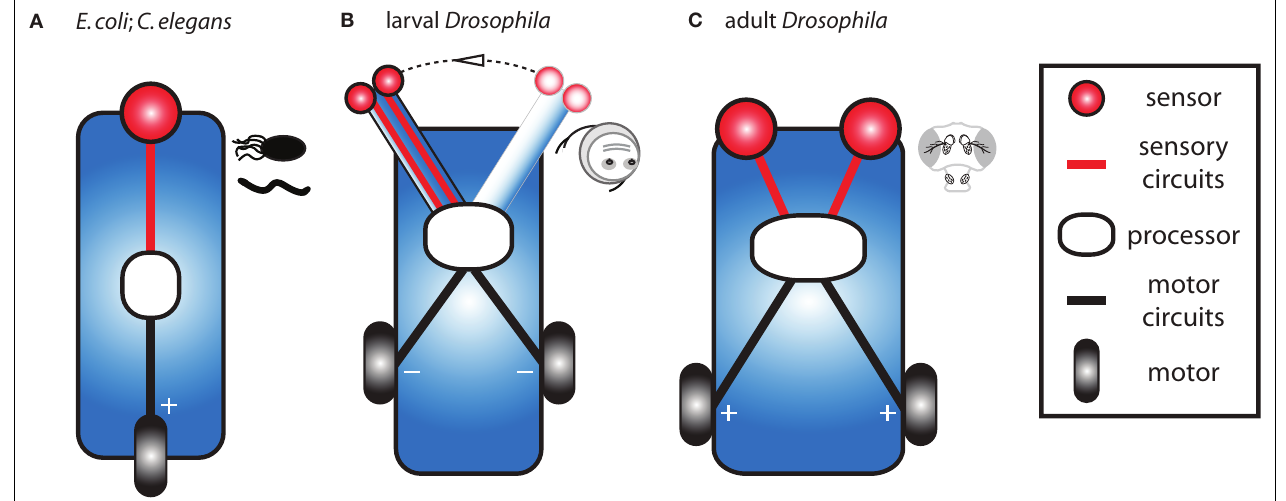
FIGURE 4 | Design of three main classes of Braitenberg-like vehicles inspired by real biological systems. (A) Our type A vehicle is akin to E. coli and C. elegans and corresponds to the original Braitenberg’s “Vehicle 1” (Braitenberg, 1984, pp. 3–5). This vehicle has a single fi xed sensor which directly activates a single motor. (B) Our type B vehicle, analogous to Drosophila larvae, is similar to Braitenberg’s “Vehicle 3a” (Braitenberg, 1984, pp. 10–12). It has two sensors in close proximity at the tip of a laterally swinging head and sensor activation